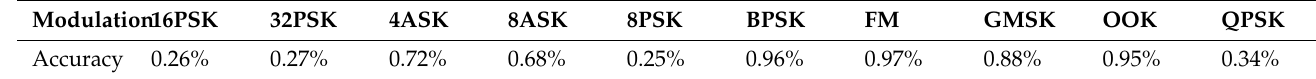
Table 5. Accuracy for each